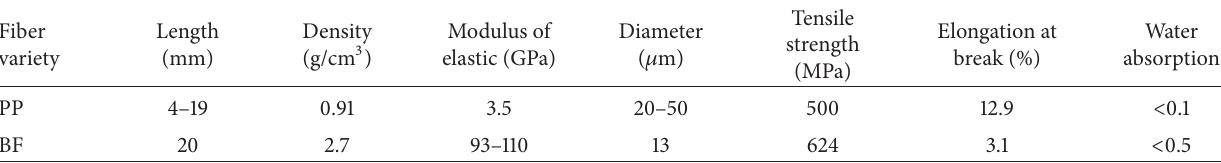
Table 3: The physical and mechanical properties of PP fiber and BF.